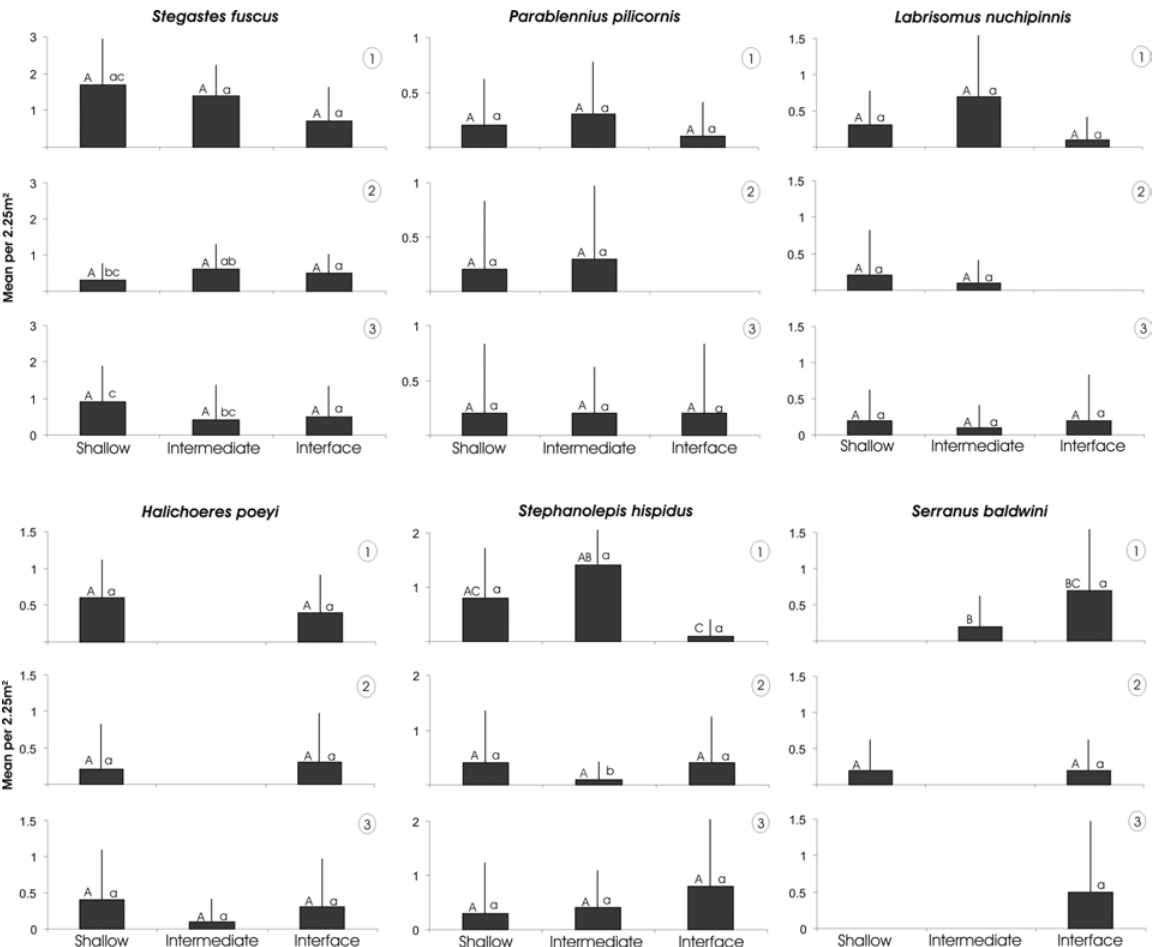
Fig. 4 – Means of density of most representative species sighted in OD patches at Maramutá reefs. Numbers in circle indicates samples (period); letters above bars indicates homogeneous groups from SNK test. Capital letters refers to comparisons depth on the same time while minuscule letters refers to comparisons depth on different